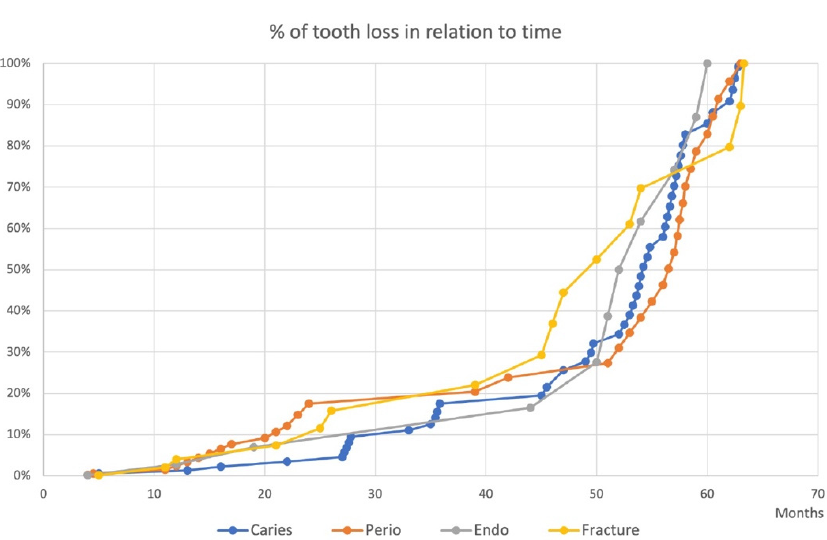
Figure 1. Percentage of tooth loss in relation to time. Each curve illustrates the percentage of tooth loss in relation to time for each individual category. Less than 20% of tooth loss occurred within